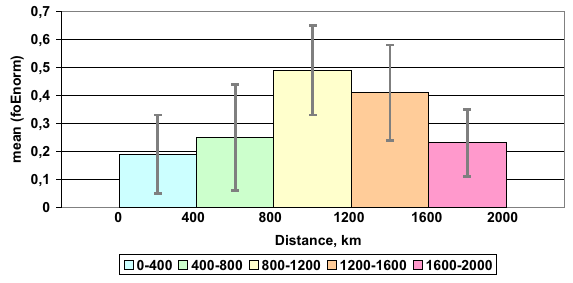
Table 1. Correlation coefficient between foEnorm and